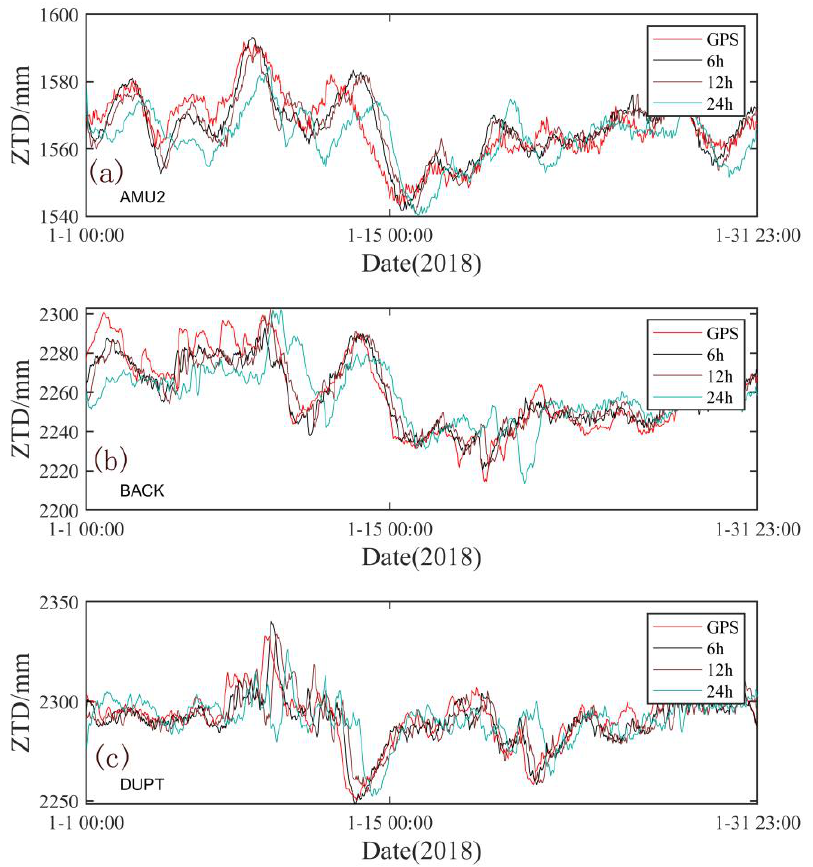
Figure 11. Distribution of correlation coefficient R, bias, and RMS between the forecasting results and GPS-ZTD (( a ), ( d ) and ( g ) are six-hour forecast results; ( b ), ( e ) and ( h ) are 12 h forecast results; ( c ), ( f ) and ( i ) are 24 h forecast results).